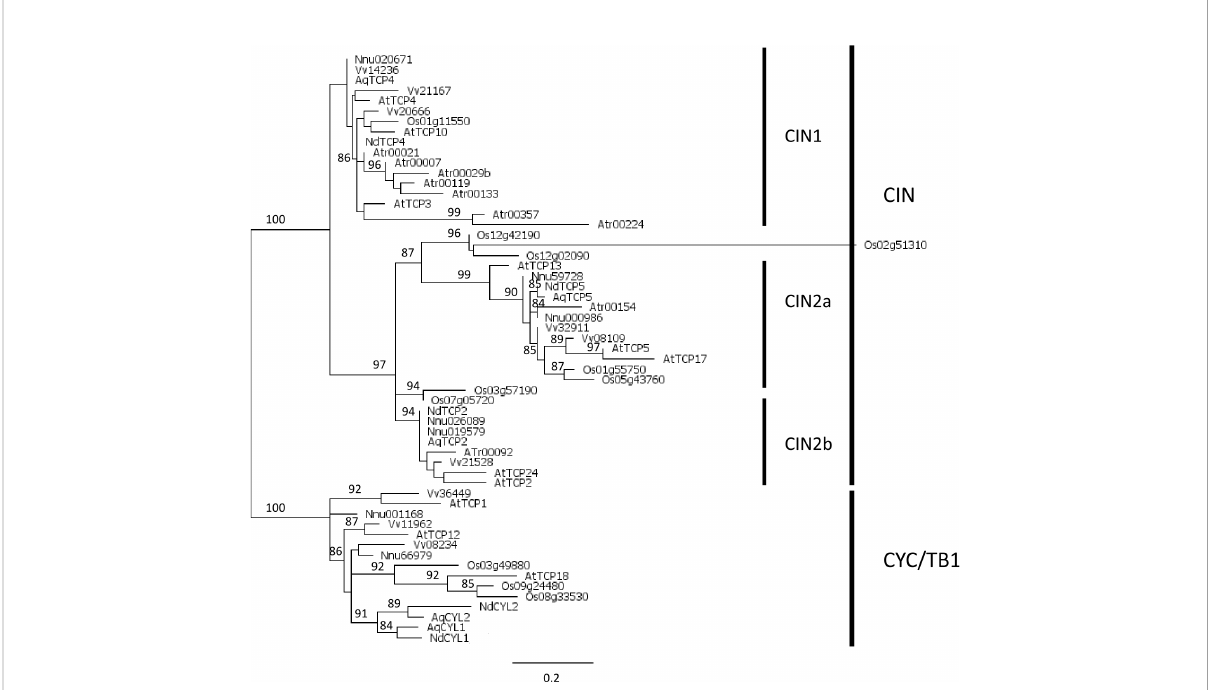
FIGURE 2 Phylogeny of class II TCP proteins in the complete inferred proteomes of Amborella trichopoda (Atr), Arabidopsis thaliana (At), Vitis vinifera (Vv), Nelumbo nucifera (Nnu), Aquilegia coerulea (Aq), Oryza sativa (Os), and the fi ve proteins deduced from the fl oral trancriptome of Nigella damascena (Nd). Maximum likelihood reconstruction was done with PhyML and based on the alignment of 61 amino acid positions that included the TCP domain. Branch support values above 80% are indicated (a-LRT